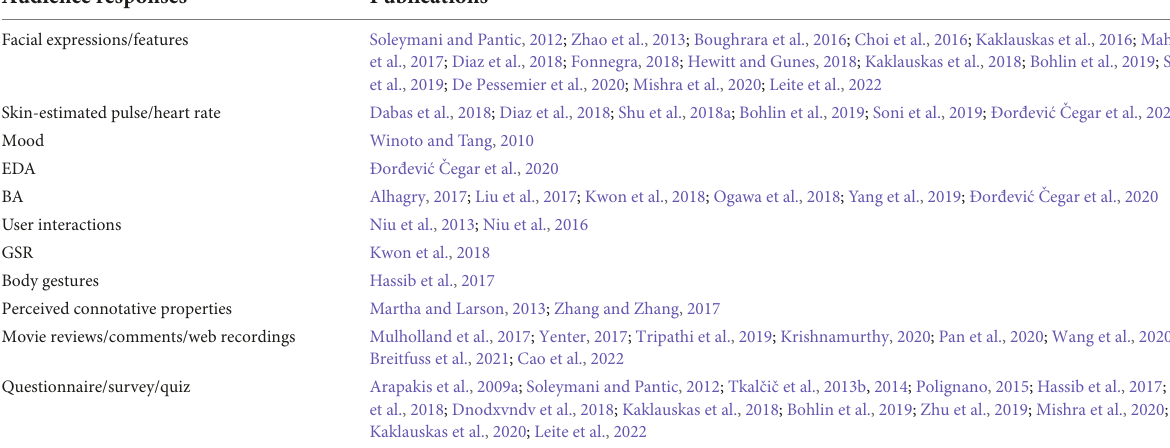
TABLE 5 The audience responses in different publications.